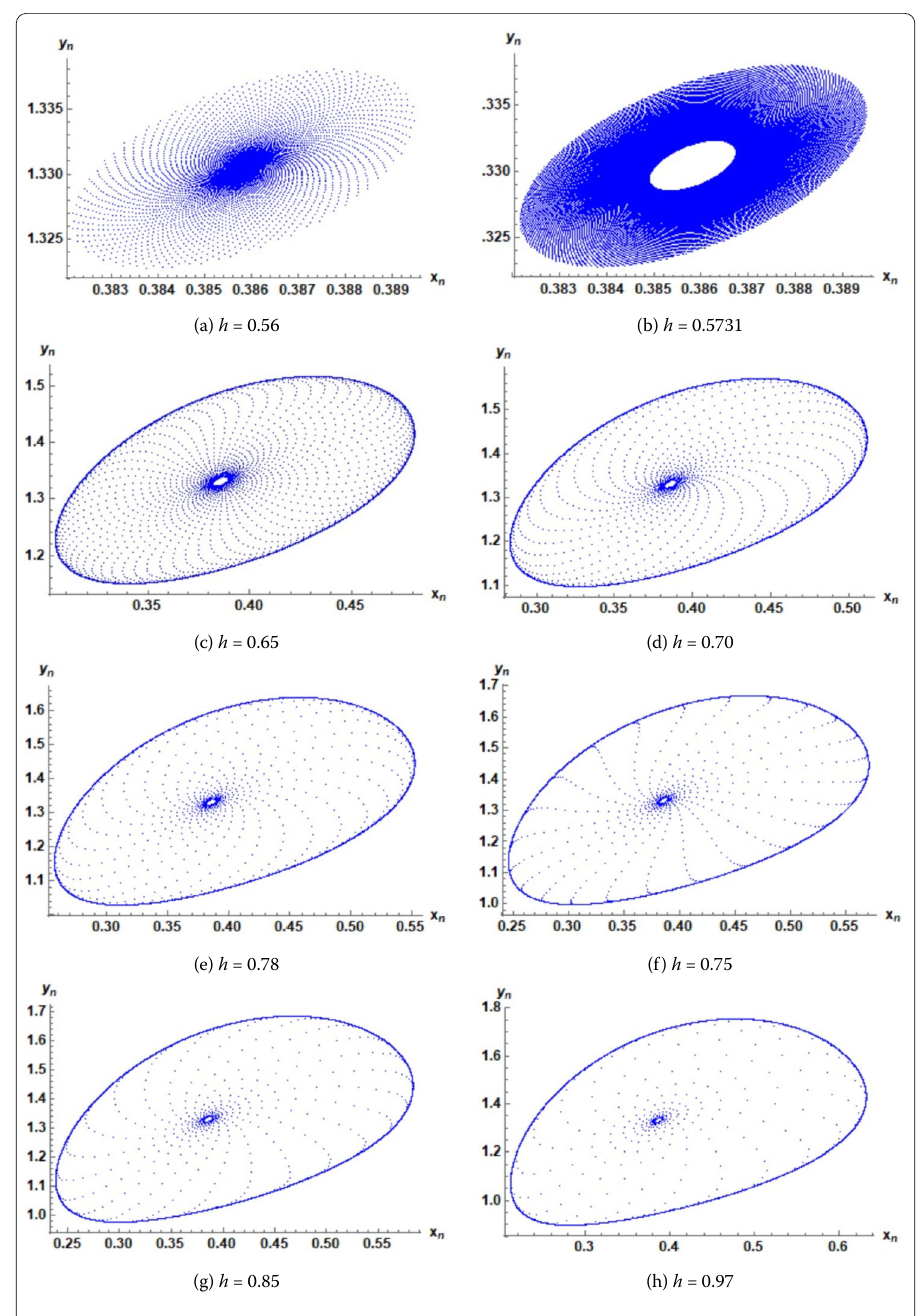
Figure 6 Phase portraits for model (2) at different values of h with ( a , b , c , d , α , β ) = (0.001,0.75,0.224,0.29,0.19,1) and initial conditions ( x 0 , y 0 ) = (0.38564,1.33674)